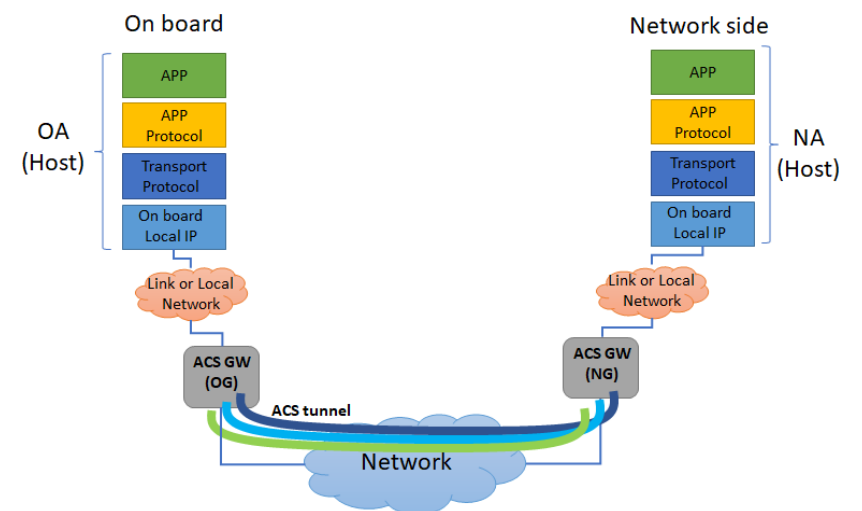
Figure 3. ACS Protocol